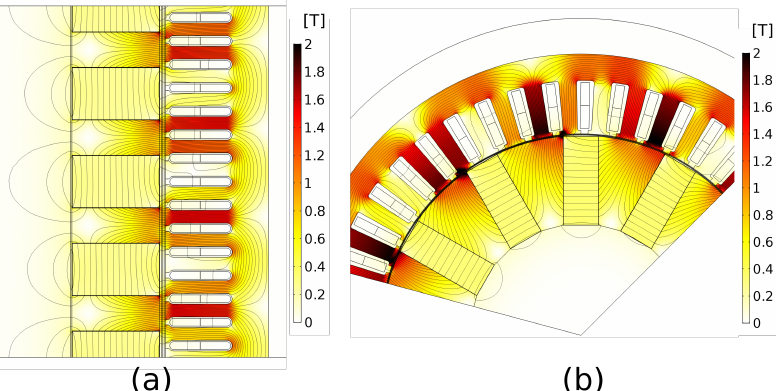
Figure 4. Magnetic flux density for the linear and rotating default cases under load in ( a , b ), respec- tively. The lower current density of J rms = 2 A/mm 2 of the linear machine will cause an inclination of the magnetic flux in the stator, but less increase in saturation. The higher current density of J rms = 5 A/mm 2 for the rotating machine will cause high local saturation, causing an increased amount of magnetic flux entering the PM on the upper boundary.